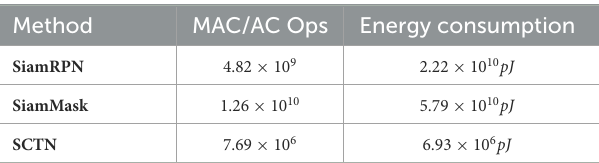
TABLE 3 Energy consumption of two ANN-based trackers and SCTN on processing a frame or a segment during